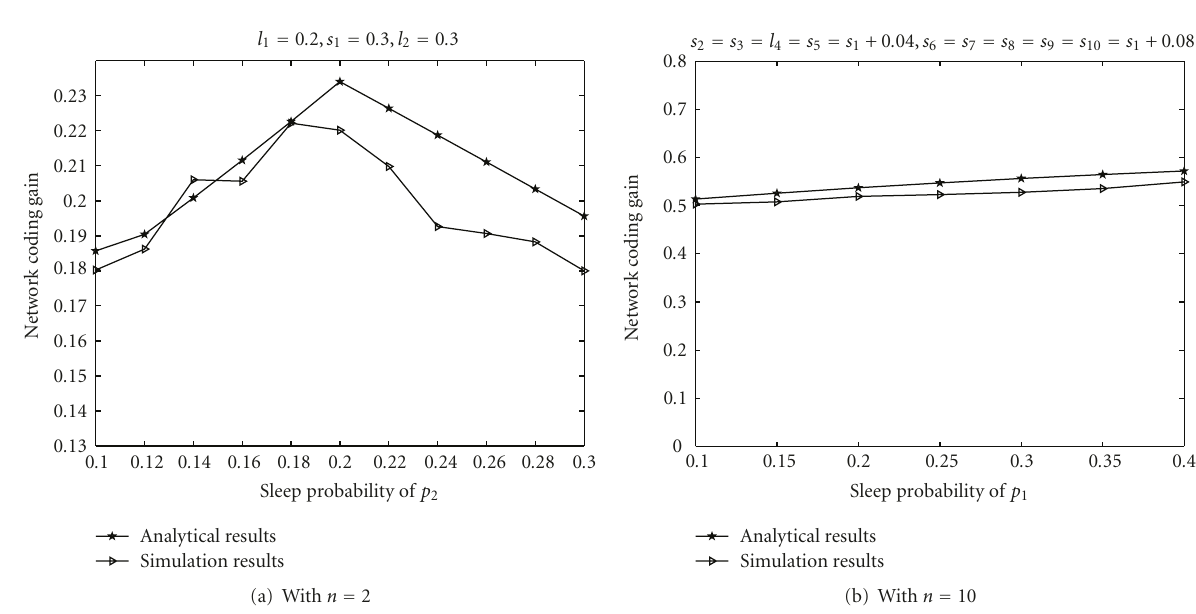
Figure 7: Network coding gain versus sleep probability of